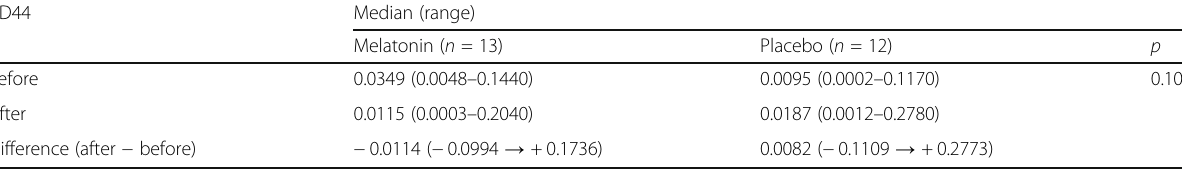
Table 2 Concentration of CD44 expression before and after melatonin and placebo administration CD44 Median (range) Melatonin ( n = 13) Placebo ( n = 12) p Before 0.0349 (0.0048 – 0.1440) 0.0095 (0.0002 – 0.1170) 0.103 After 0.0115 (0.0003 – 0.2040) 0.0187 (0.0012 – 0.2780) Difference (after − before) − 0.0114 ( − 0.0994 → + 0.1736) 0.0082 ( − 0.1109 → +